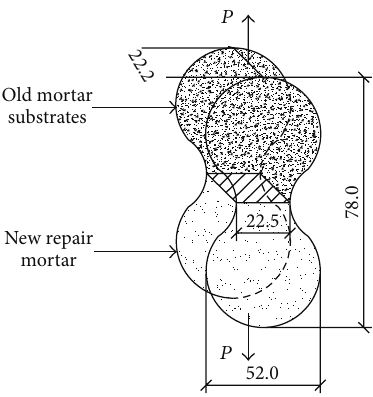
Figure 1: Composite specimens for bond strength test.